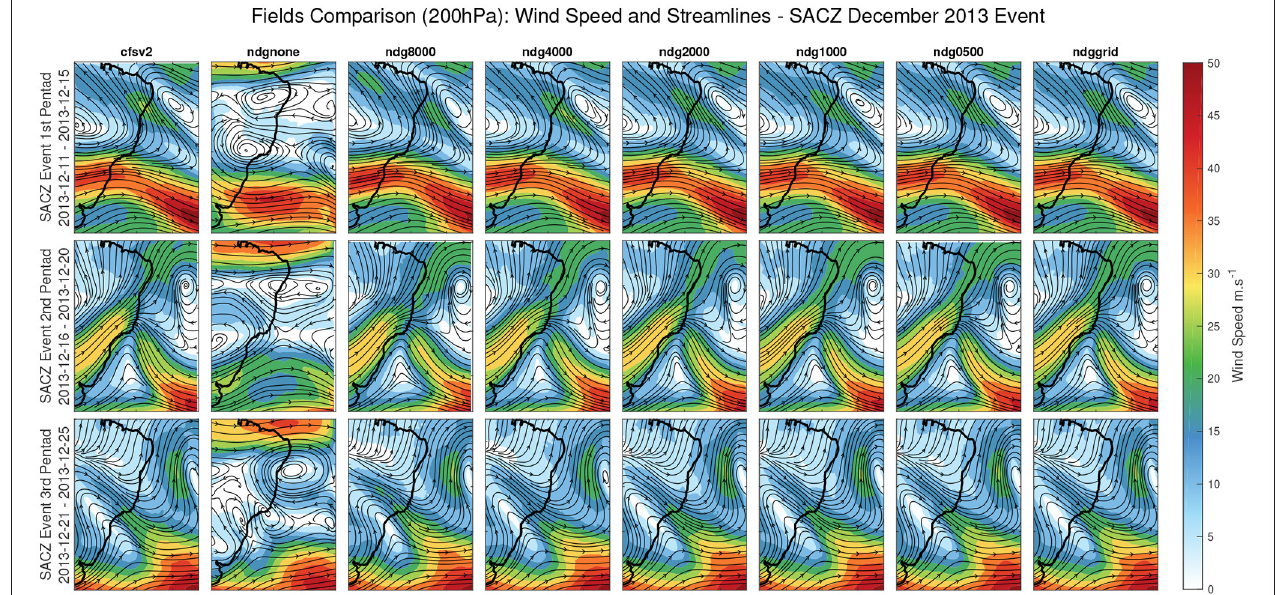
FIGURE 4 | Wind speed (filled contours, in m . s − 1 ) and streamlines at 200 hPa. Top, middle and bottom rows show averages calculated for the first, second and third pentads of the SACZ event, respectively.